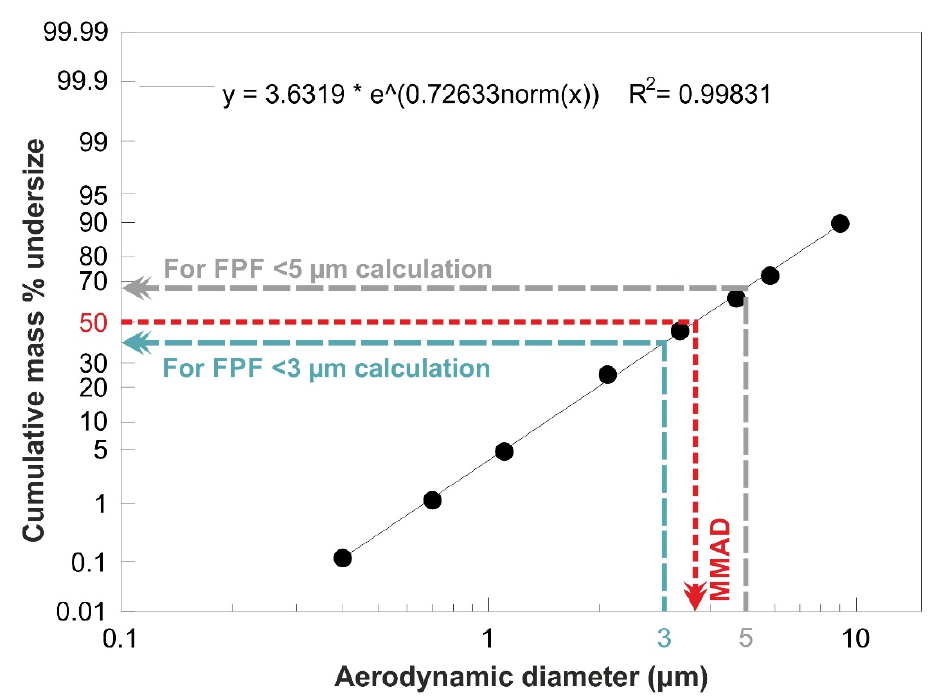
Figure A1. Curve from the KaleidaGraph 4.0 software, which was applied to the calculation of the aerodynamic properties.